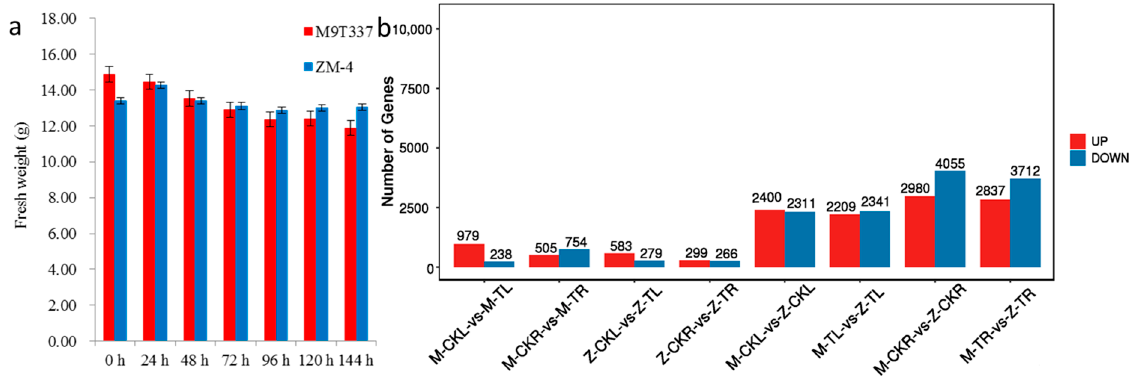
Figure 1. Fresh weight of ZM-4 and M9T337 and differential-expression genes (DEGs) in different combinations under salt stress. ( a ) Fresh weight of ZM-4 and M9T337 after NaCl treatment. ( b ) The number of DEGs in different combinations.